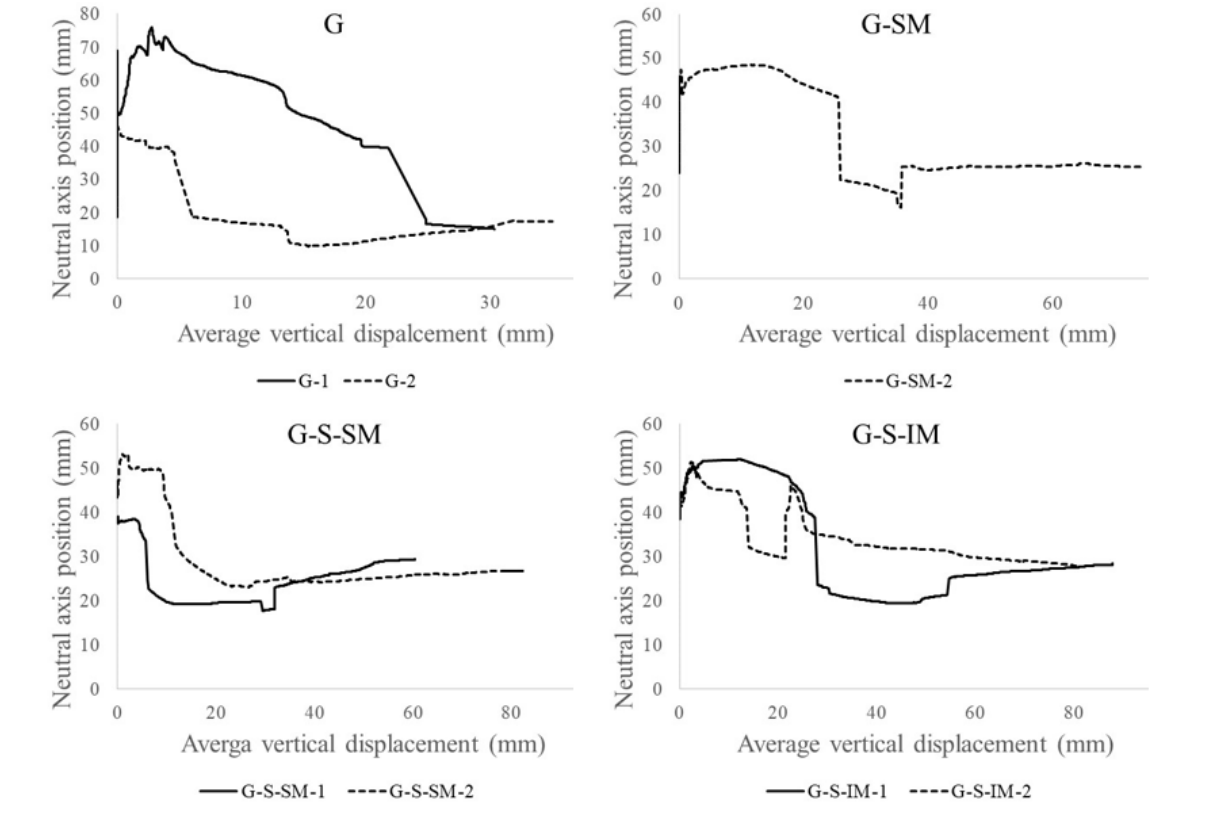
Figure 8. Neutral axis-average vertical displacement